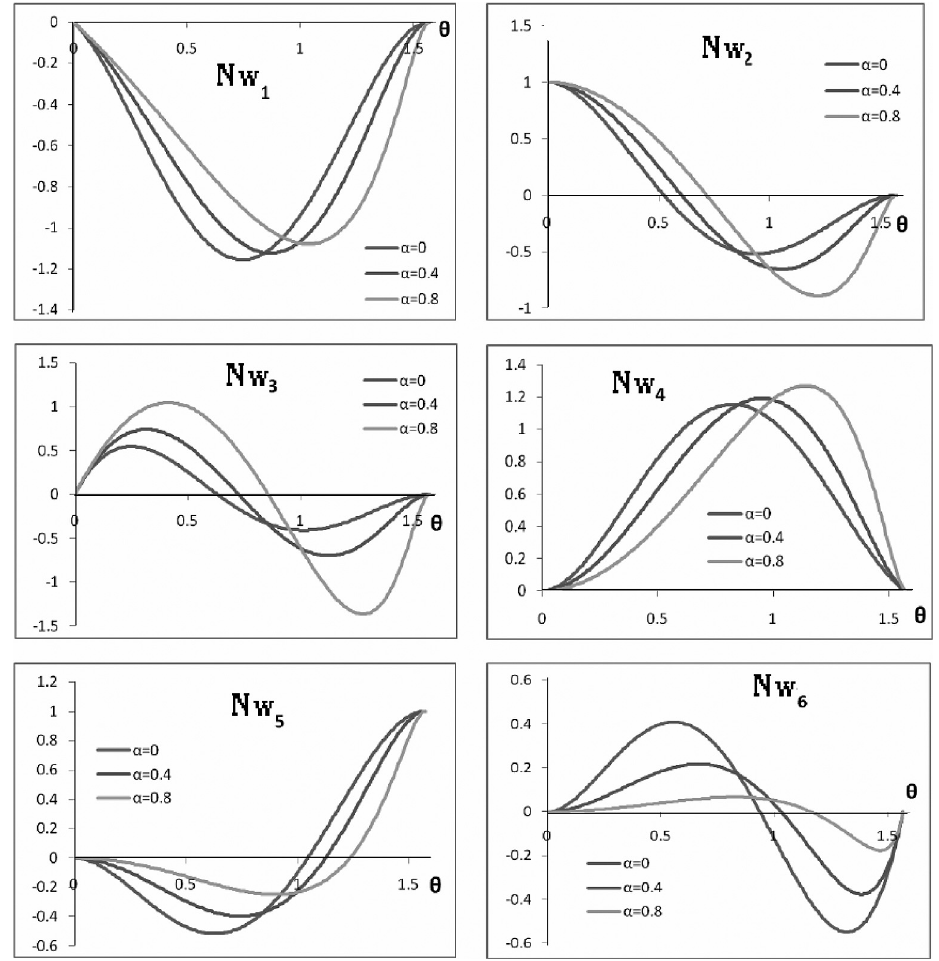
Fig. 8. Variation of radial shape functions N w with taper